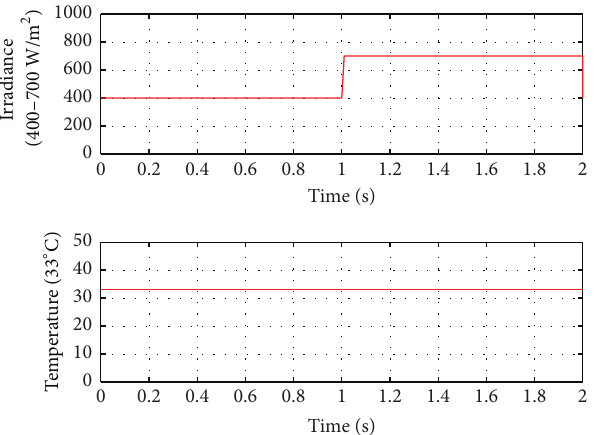
Figure 17: Temperature (constant) and irradiance (step) input